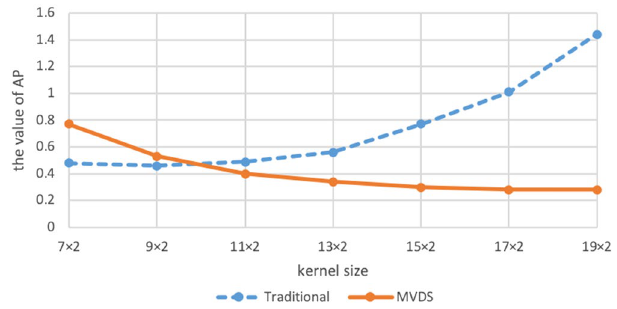
Figure 5. The effect of using different kernel sizes for both MVDS and uniform subsampling.